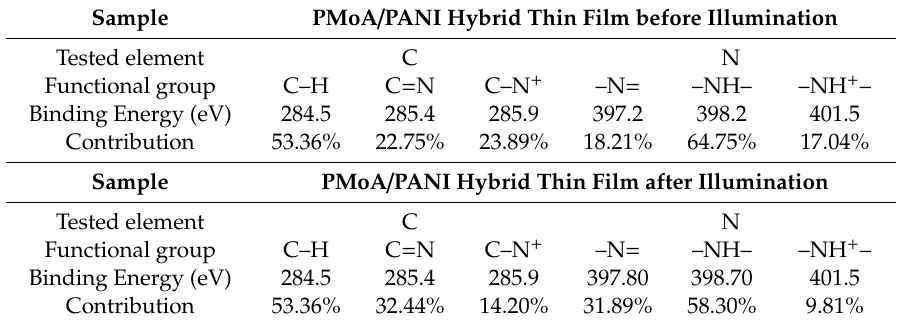
Table 4. Comparison of C– and N—containing functional groups of PMoA / PANI hybrid thin films before and after optical-light